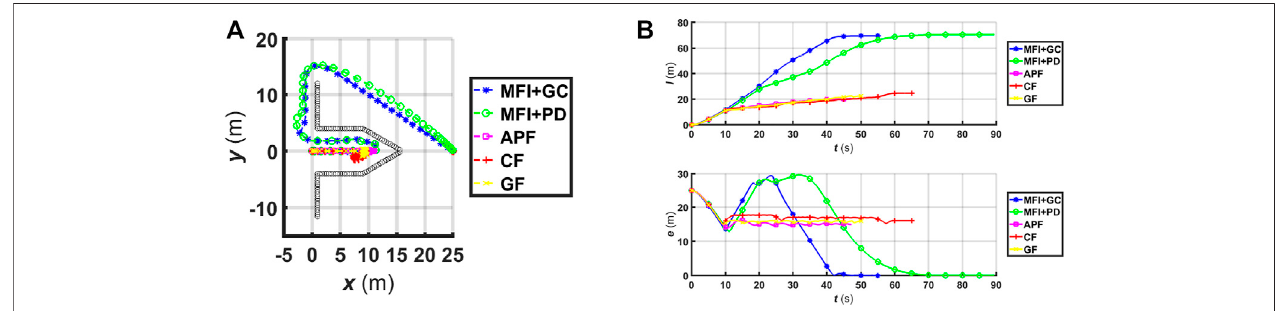
FIGURE7|(A) Therobot ’ strajectorydrawnindashed lines.Theenvironmentconsistsofasharpcorner obstacle. (B) Theplot ofthe covered trajectoryl(t) and the positional error e(t) as function of time for 2D sharp corner environments.